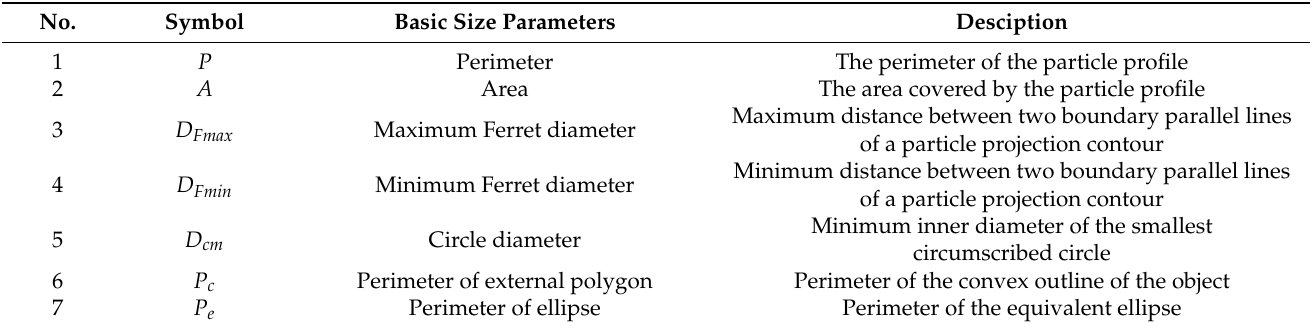
Table 2. Definition of fundamental dimensions of